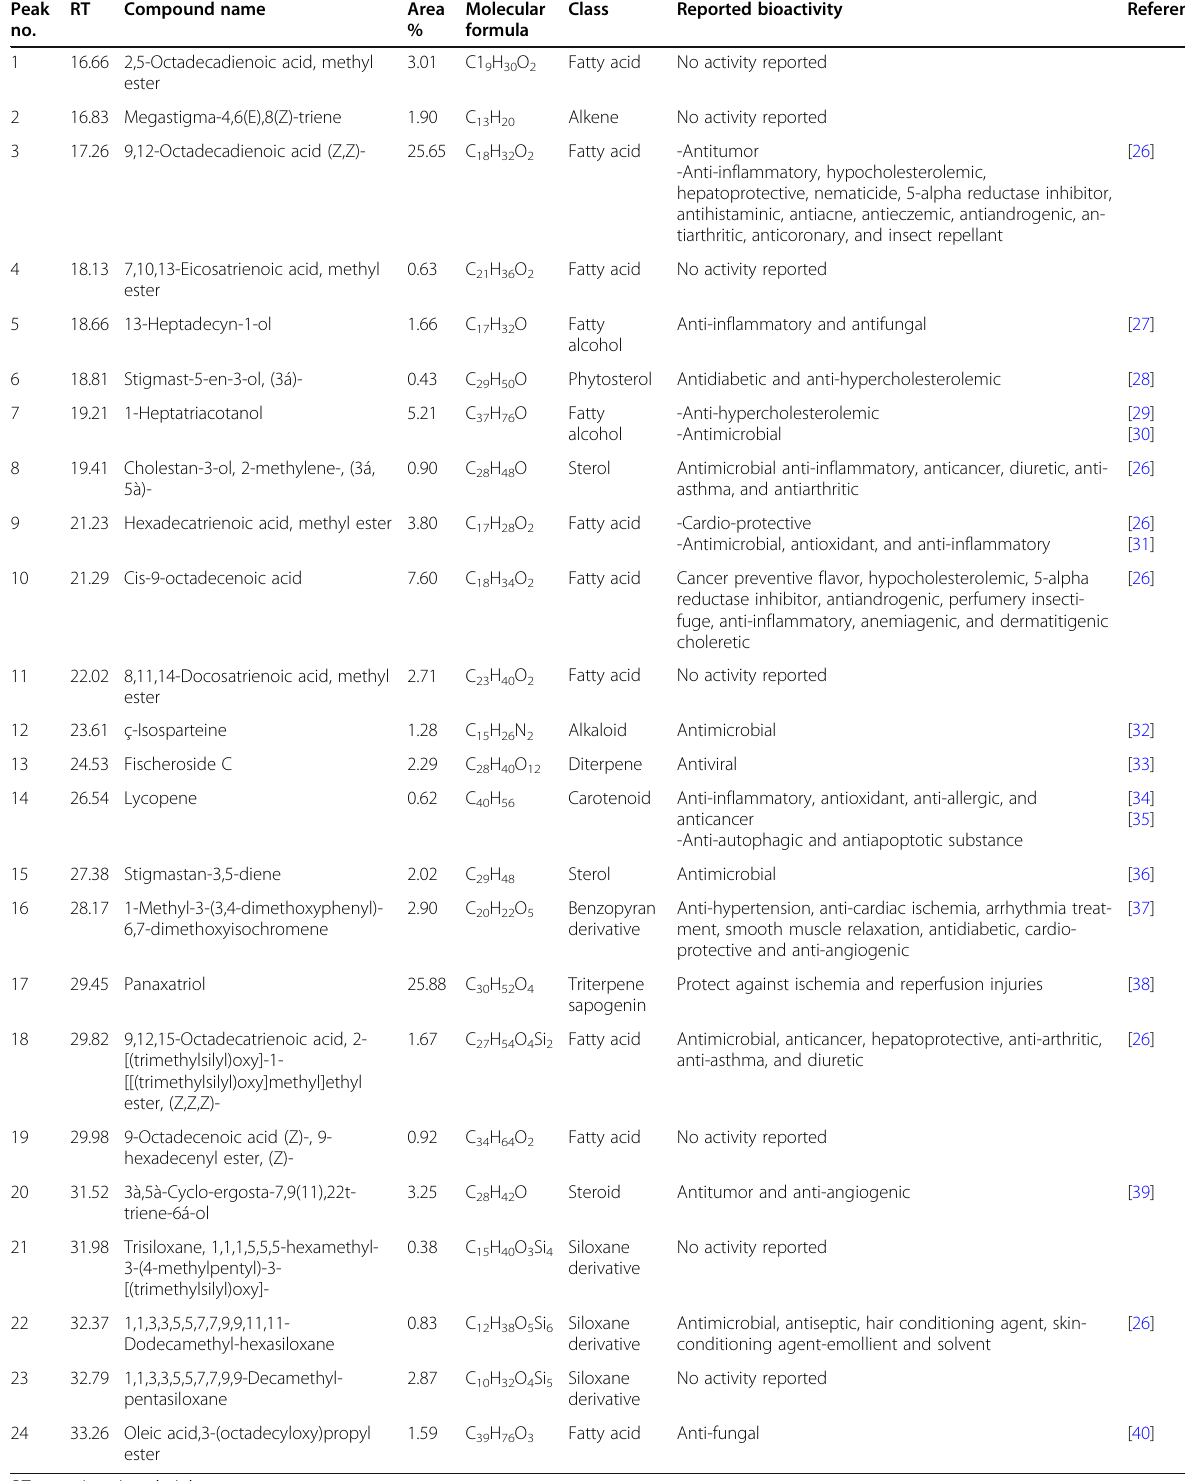
Table 4 Phytochemical components of Varthemia candicans ethanolic extract as identified by GC-MS analysis Peak